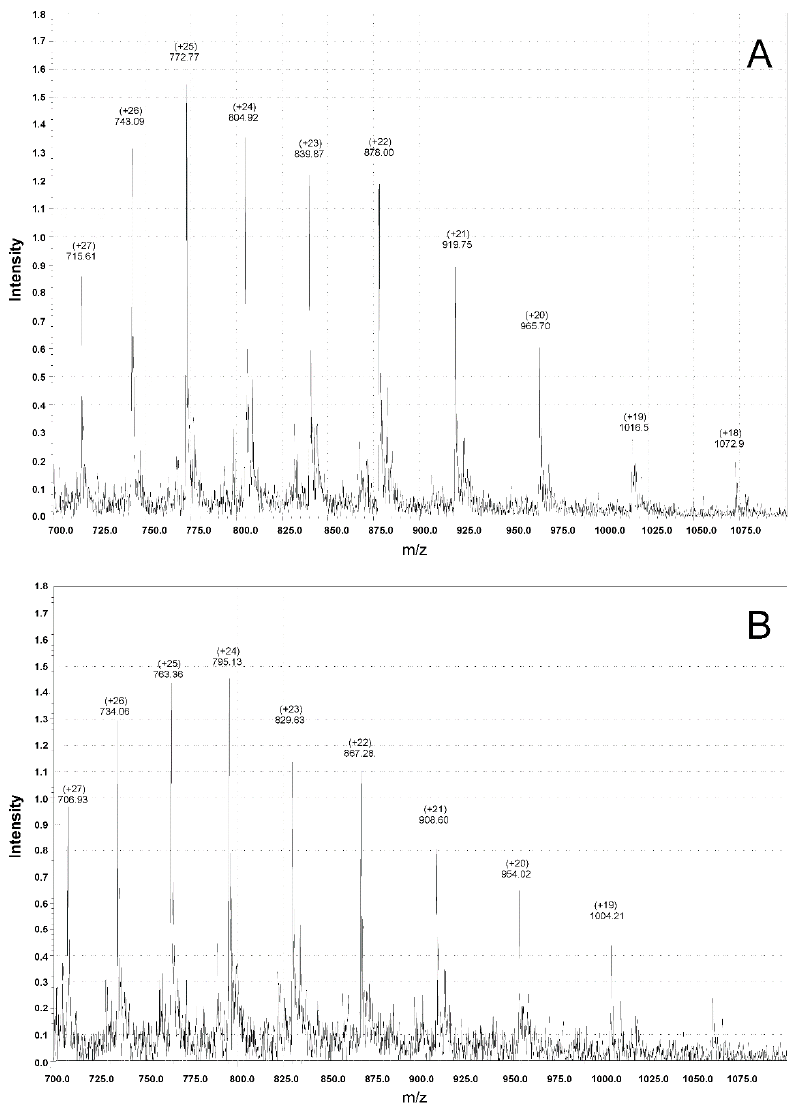
Figure 4. ESI-MS spectra of macaque ( A ) and murine ( B ) rIL-11 samples. m / z values and their respective relative charge values (+z) are indicated above the major peaks.